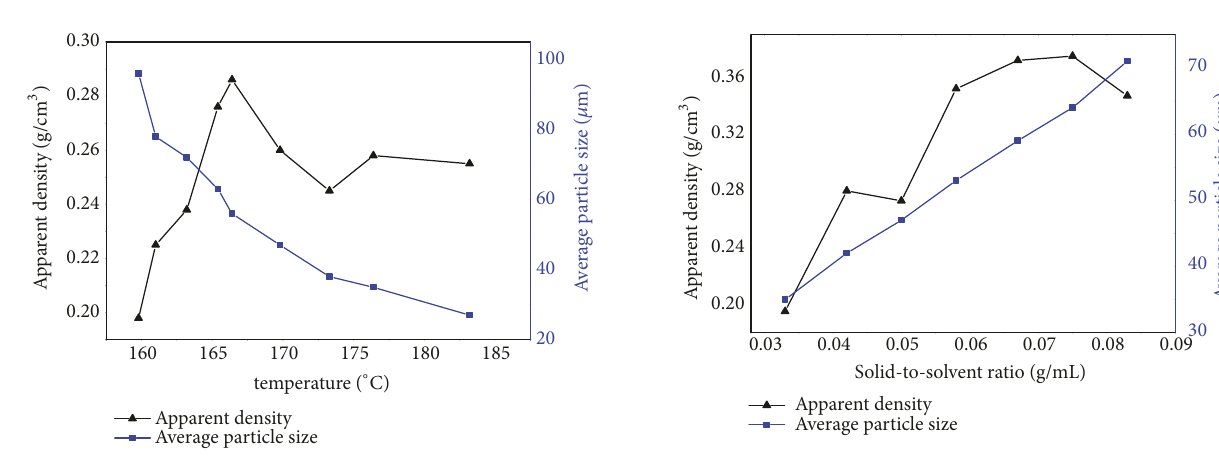
Figure1:Plotsofaverageparticlesizediameterandapparentdensity of PP powders with dissolution temperature.